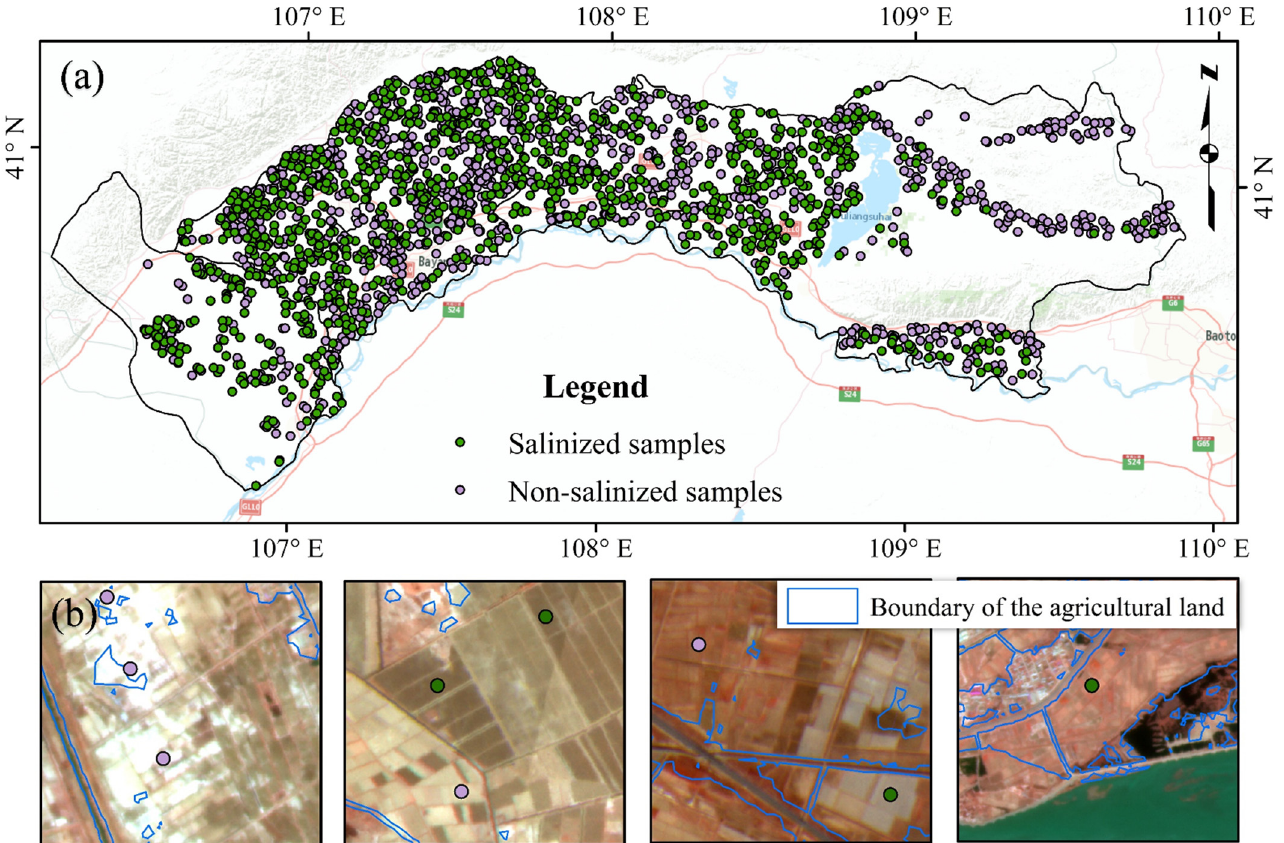
Figure 2. ( a ) The distribution of the samples of saline and non-saline cropland, ( b ) the samples in the false color composited PlanetScope image (R: NIR band, G: Green band, B: Blue band).